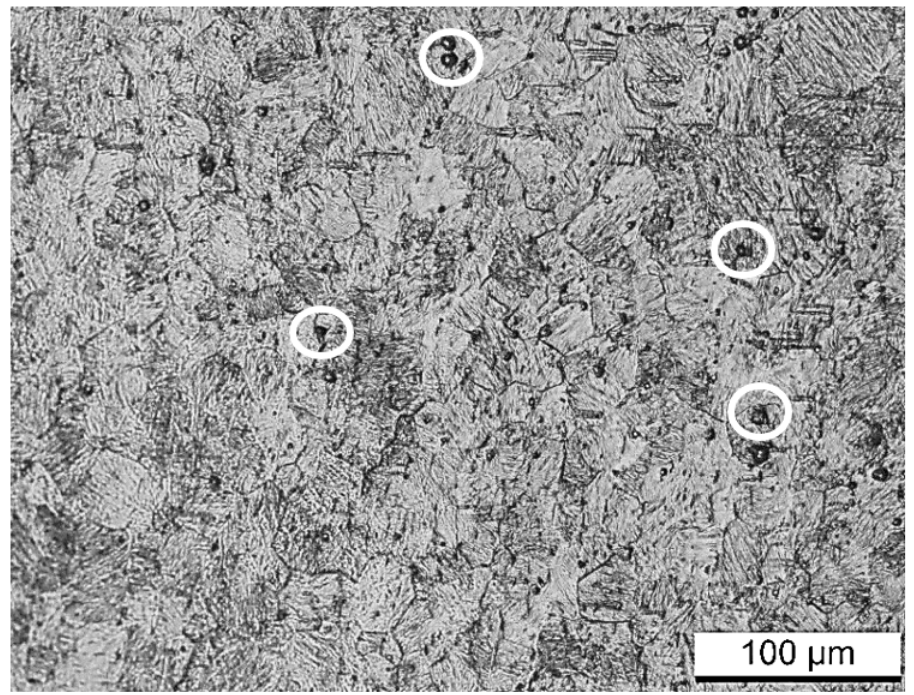
Figure 1. Optical micrograph of as-received Nitinol. The twinned nature of the microstructure is evident from the lamellar structure. This indicates the presence of the martensite phase. The average grain size of the material was found to be 38 ± 5 μ m. About 100 grains were counted for determining the average grain size. A few dark particles (shown by white circles) were also observed in the microstructure. These were precipitates of Ni-Ti-C as verified through energy dispersive spectroscopy measurements on the scanning electron microscope.